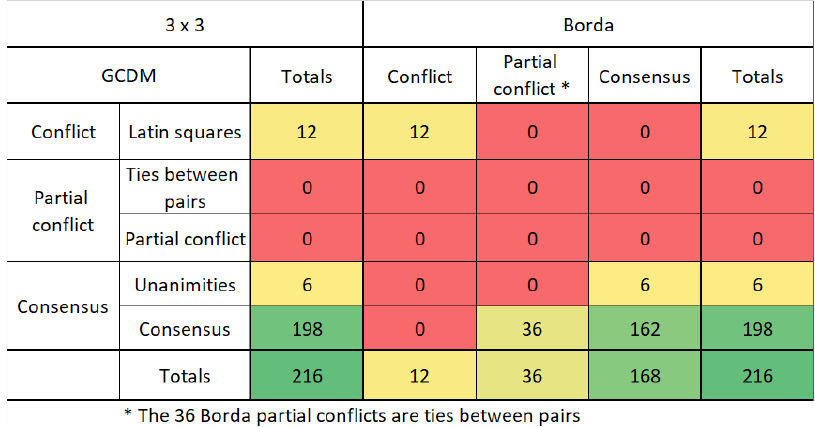
Figure 24. GCDM transformation of Borda conflicts and consensus for 3 × 3 matrices.